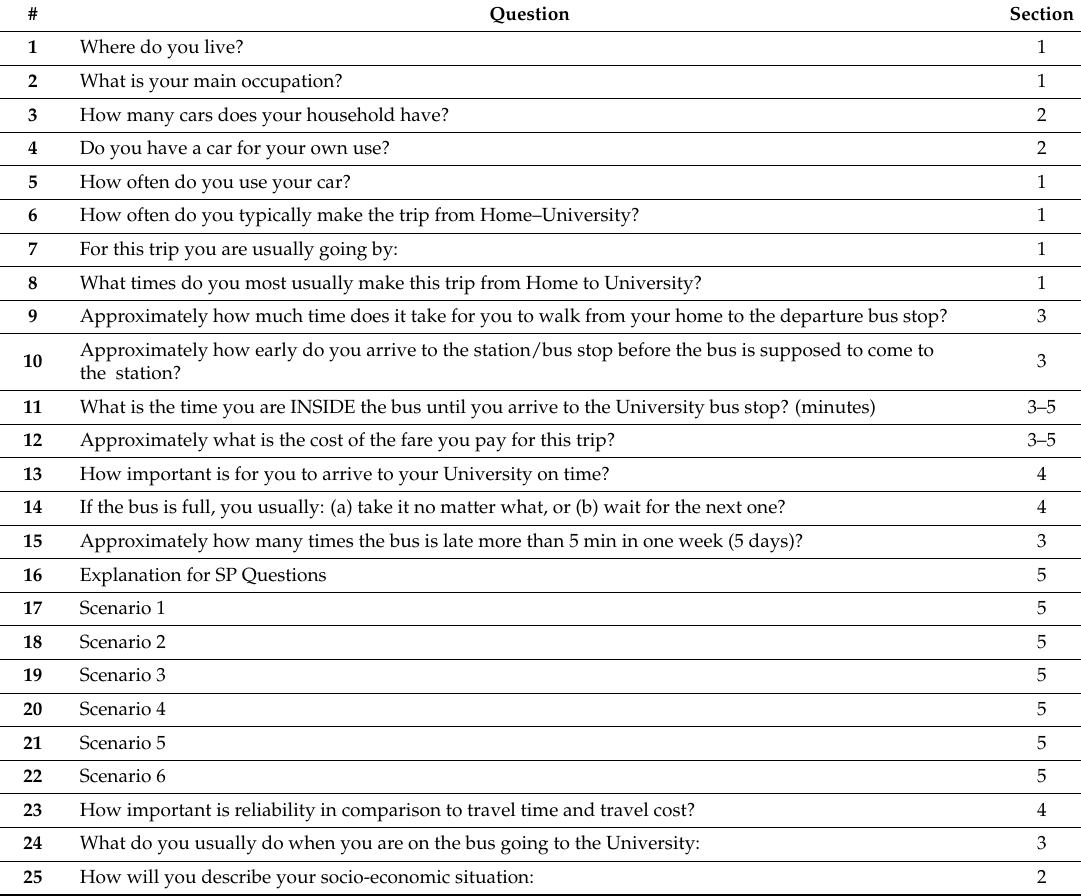
Table 1. Questionnaire and corresponding